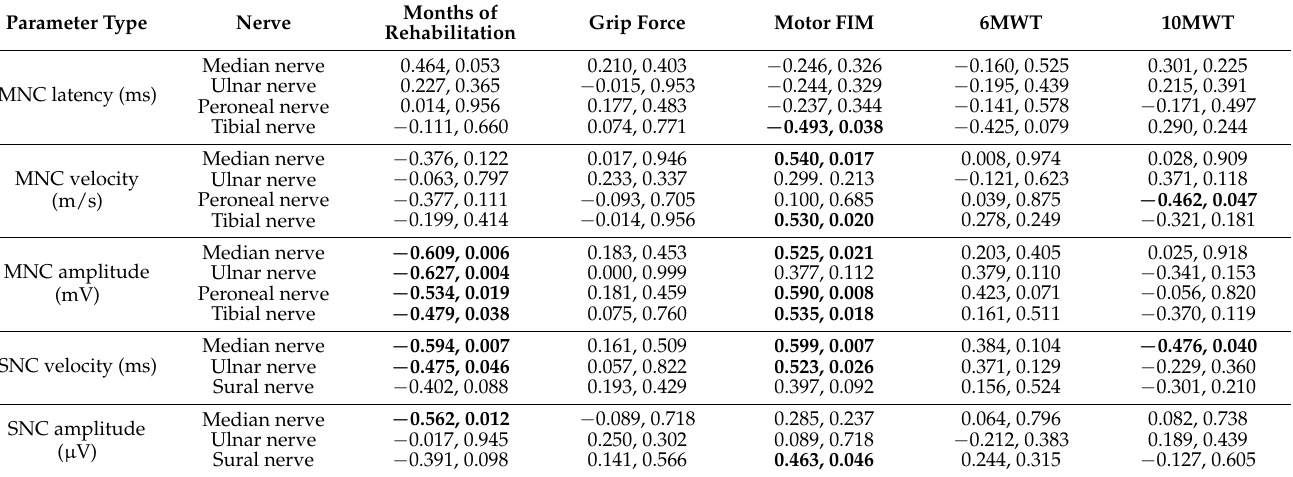
Table 4. Significant Spearman’s correlation coefficient, r, found between the electrophysiological mea- surements, the Motor Nerve Conduction (MNC) and Sensory Nerve Conduction (SNC), and factors of the rehabilitation durations, as well as measurements at discharge of functional independence measure (FIM), 6 minute walk test (6MWT), and 10 m walk test (10MWT). Significant correlation are in bold